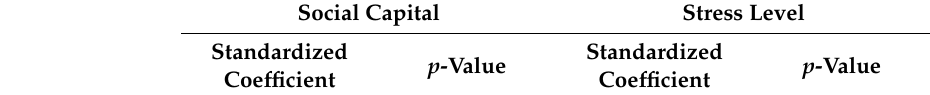
Table 2. The relationships between socio-demographic characteristics, social capital, and stress